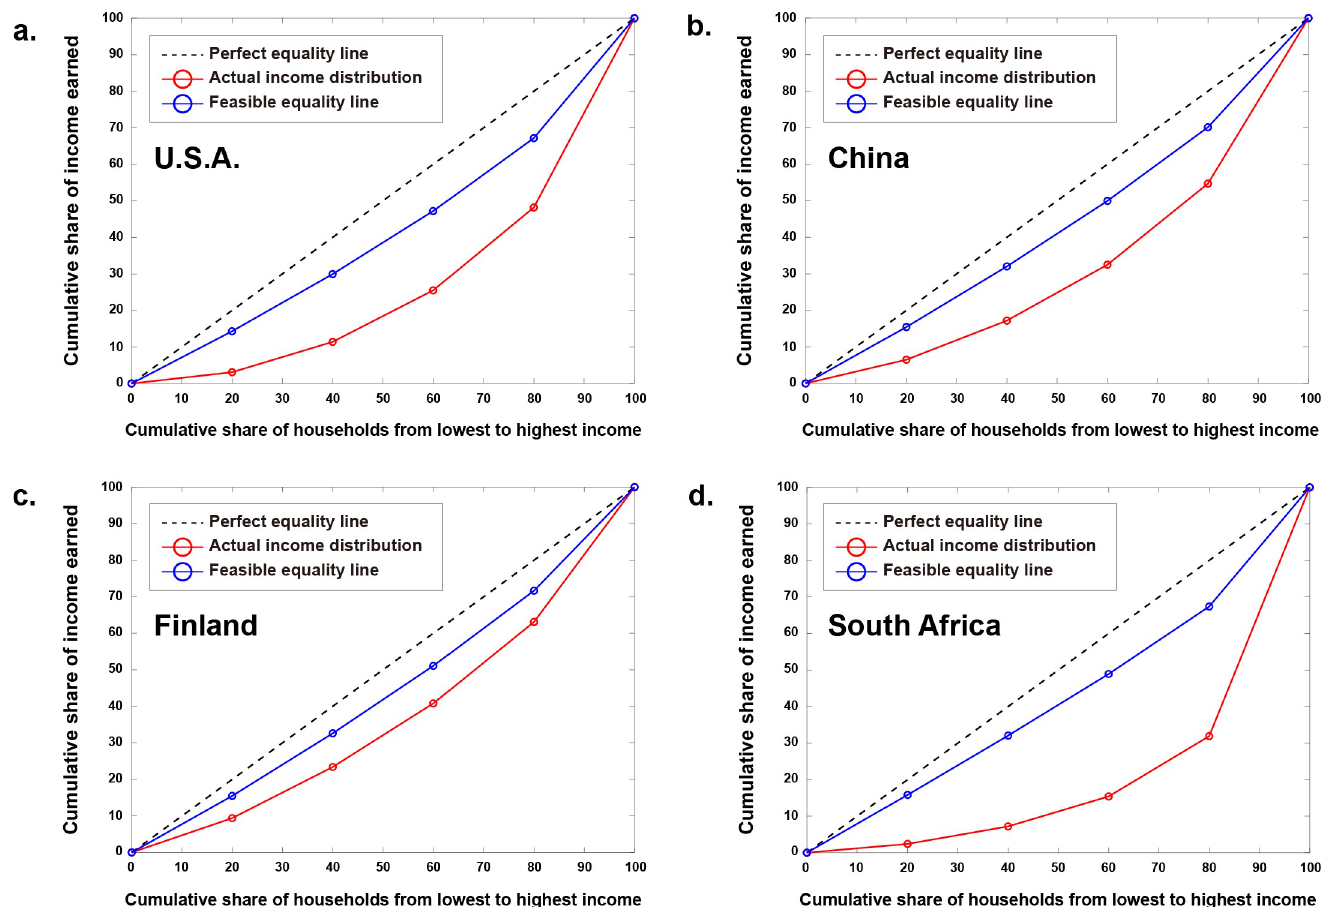
Fig 6. Lorenz curves for the actual and the optimal income distributions in four countries. The corresponding Gini coefficients can be found in Table 3. Note that the feasible equality lines (blue) are similar in all countries.